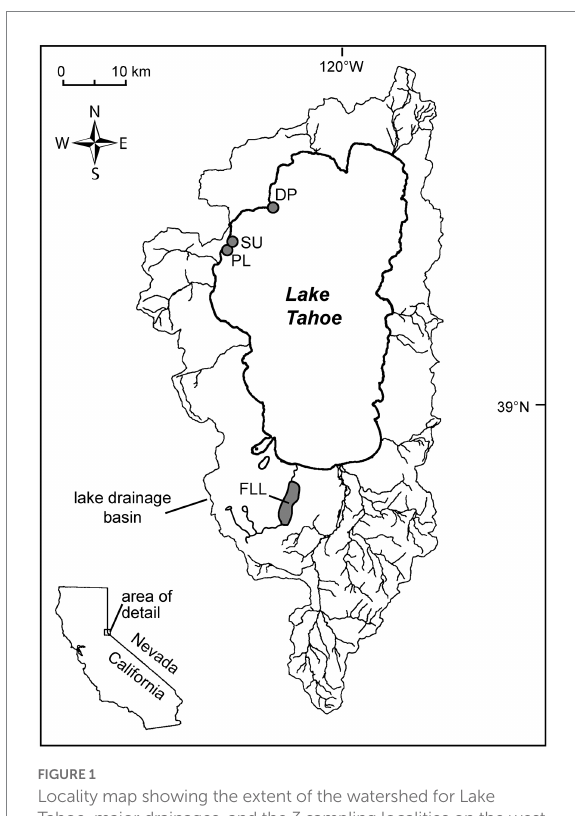
FIGURE 1 Locality map showing the extent of the watershed for Lake Tahoe, major drainages, and the 3 sampling localities on the west shore. SU: Sunnyside Harbor; PL: Pineland, and DP: Dollar Point, FLL: Fallen Leaf